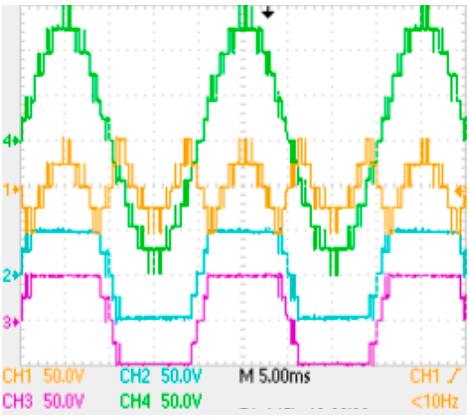
Figure 15. Switch states of Proposed strategy. (CH1: port voltage of Module 1; CH2: port voltage of